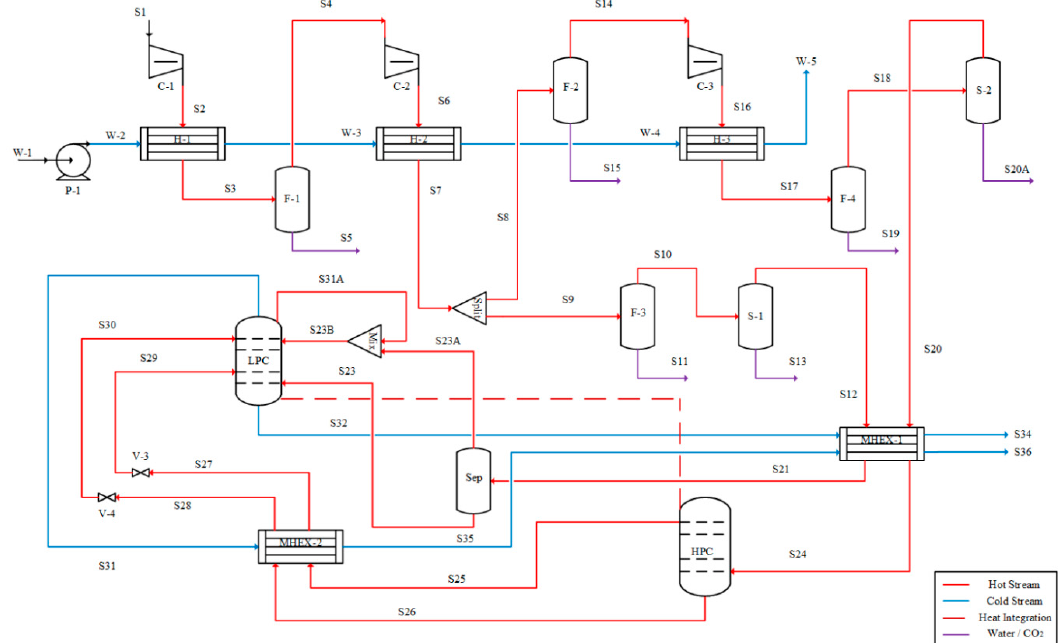
Figure 4. Process flow diagram of the ASU configuration C4.